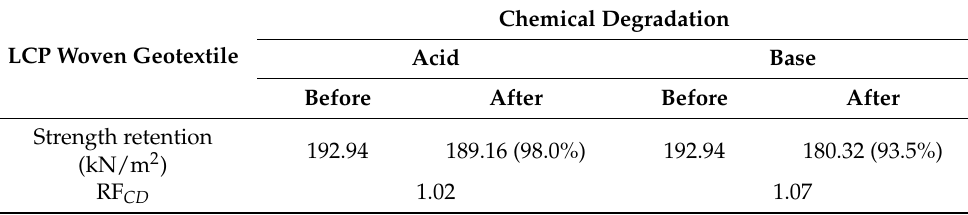
Table 6. Strength retention and reduction factor for chemical degradation of LCP woven geotextile.